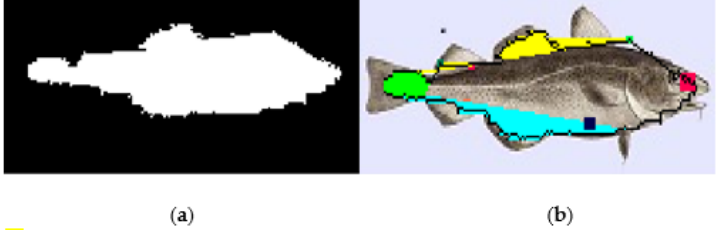
Figure 15. An example of a BMA mask ( a ) and the input image with annotated landmarks and colored fish parts that is generated as the output of the deep learning approach ( b ).